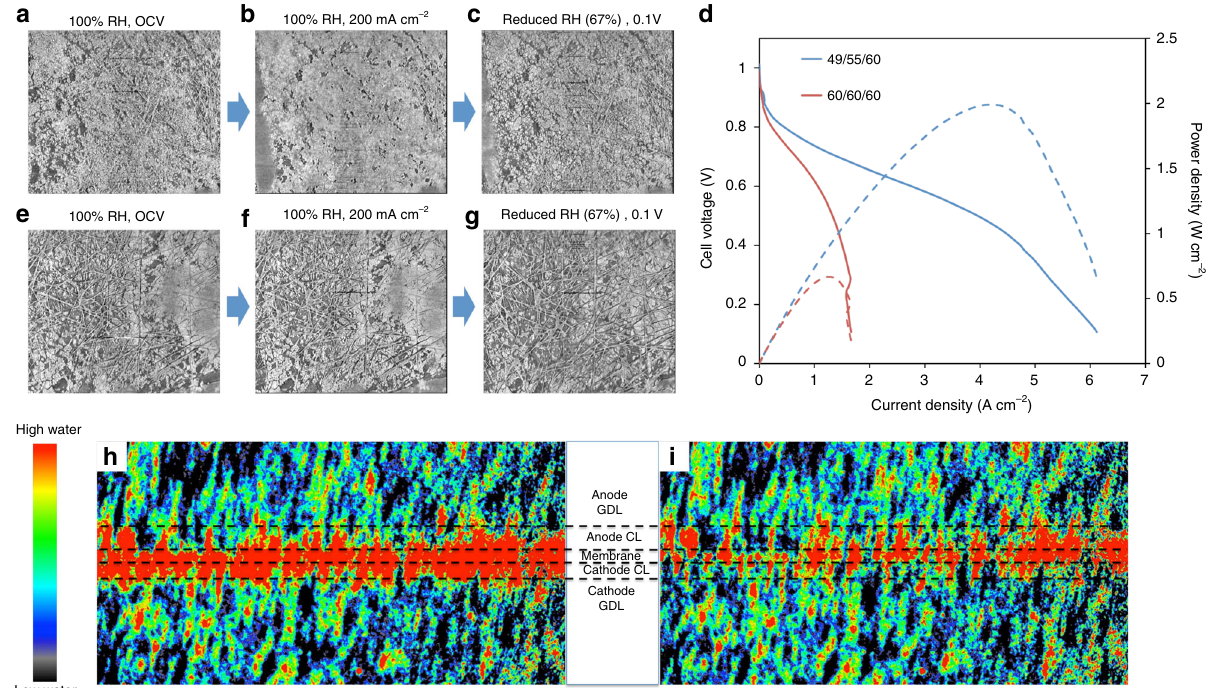
Fig. 2 Dew point effects on electrode water and cell behavior. Operando micro X-ray computed tomography (CT) scans of the interface between the GDL and CL of ( a – c ) PtRu/C anodes and ( e – f ) Pt/C cathodes at conditions of: 100% RH at open circuit voltage (OCV), 100% RH at 200 mA cm − 2 , and reduced RH (67%) at 0.1 V, respectively. The H 2 /O 2 fl ow rates were both kept at 0.2 L min − 1 . The cell temperature was kept at 28 °C (Polarization data for the operando cell is provided in Supplementary Fig. 5. d i-V (solid line) and i-power density curves (dashed line) at two different dew point con fi gurations in 5 cm 2 AMFCs. The membranes used in all tests were HDPE 5 . The 5 cm 2 cells were tested at 60 °C with H 2 /O 2 fl ows of 1 L/min. Operando neutron imaging of AMFCs at two different dew point situations: ( h ) The “ full humidity ” situation, which shows fl ooding inside the cell; ( i ) The “ reduced dew points ” situation, which shows drying out inside the cell. Anodes and cathodes used in the above three experiments had catalys loadings of 0.70 mg PtRu cm − 2 and 0.60 mg Pt cm − 2 ,